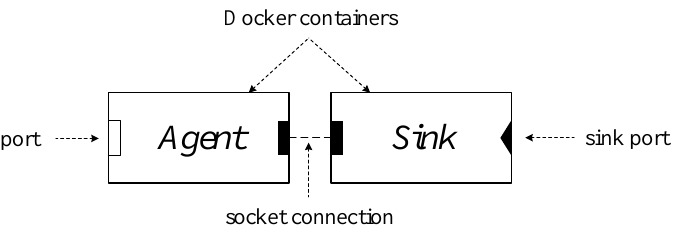
Figure 2. The basic components of an adapter. Triangular ports connect to the platform, filled rectangular ports connect the agent and the sink. Open rectangular ports connect the agent to non-FLINT sources.